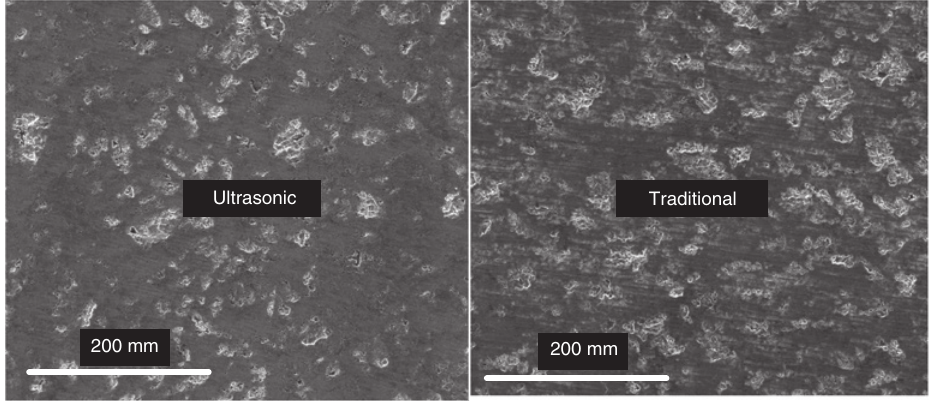
Figure 11: Broken area comparison after traditional and ultrasonic grinding.